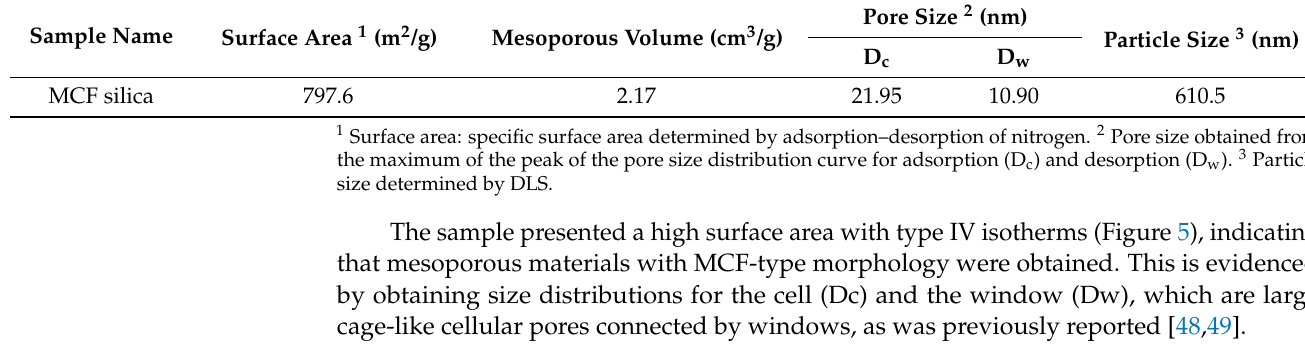
Table 3. Surface area, mesoporous volume, pore size, and particle size of MCF silica.